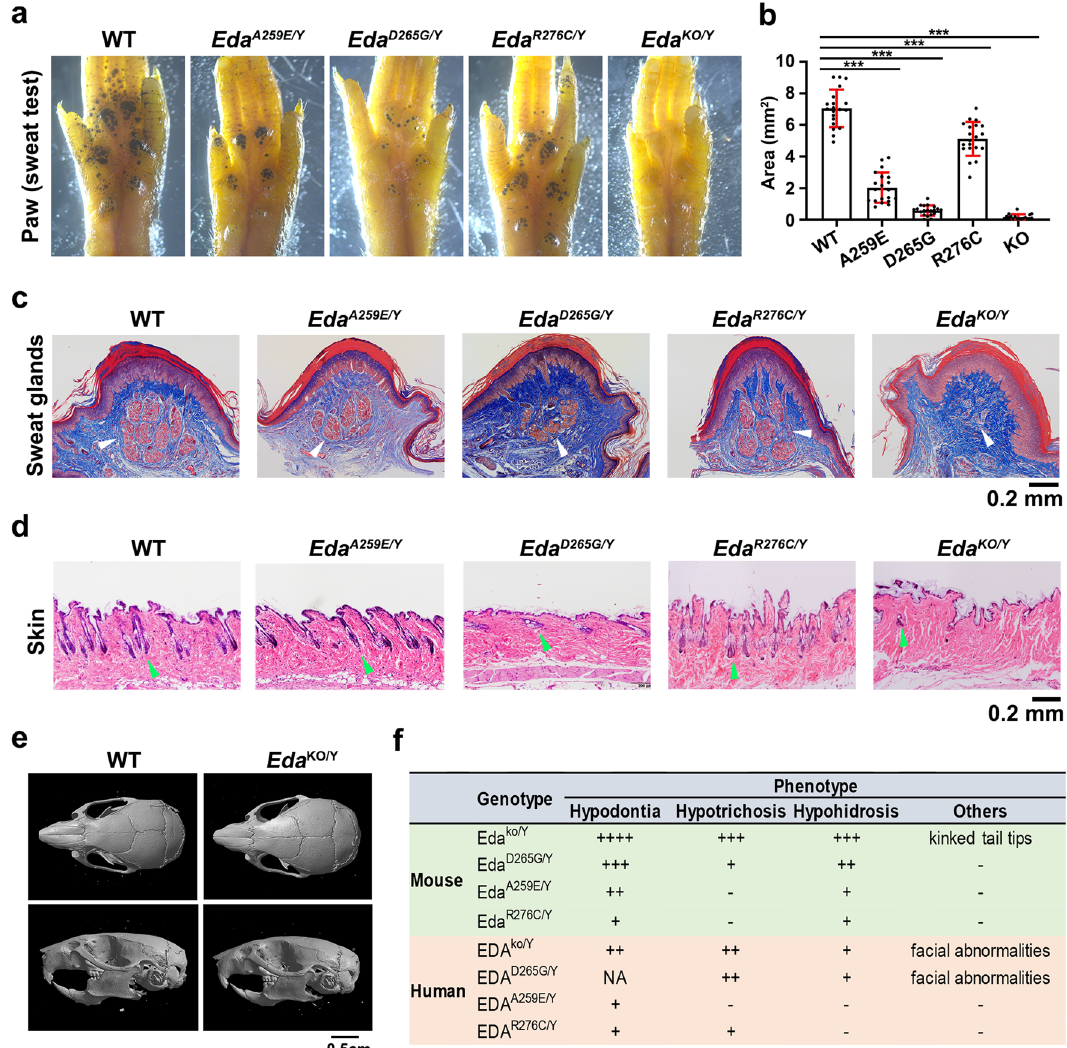
Fig. 7 | Sweat gland and hair follicle phenotypes in EDA-EDAR interaction de fi ciencymice.a SweattestofWTandmutant Eda mice.Sweatisdetectedasdark spots. b The area of sweat dark spots from a is quanti fi ed as an indication of the sweatingability.Dataarepresentedasthemean±SDfor n =9malemiceforKOand 10 for other genotypes with measurements recorded from the two hind paws of eachindividual.Atwo-sidedStudent ’ s t -testwasperformed.*** P =2.2E − 04(A259E), *** P =3.1E − 24 (D265G), *** P =3.7E − 06 (R276C) and *** P =6.3E − 24 (KO). c Histological sections of the footpads. Sweat glands are indicated by white arrowheads. Scale bar: 0.2mm. d Histological sections of the abdominal skin showing hair follicles indicated by green arrowheads. Scale bar: 0.2mm. e Micro – computed tomography ( μ CT) analysis of craniofacial phenotypes in Eda knockout and WT mice. No obvious craniomaxillofacial abnormality was observed in Eda knockout mice. f Phenotypic variations in mice and humans carrying EDA